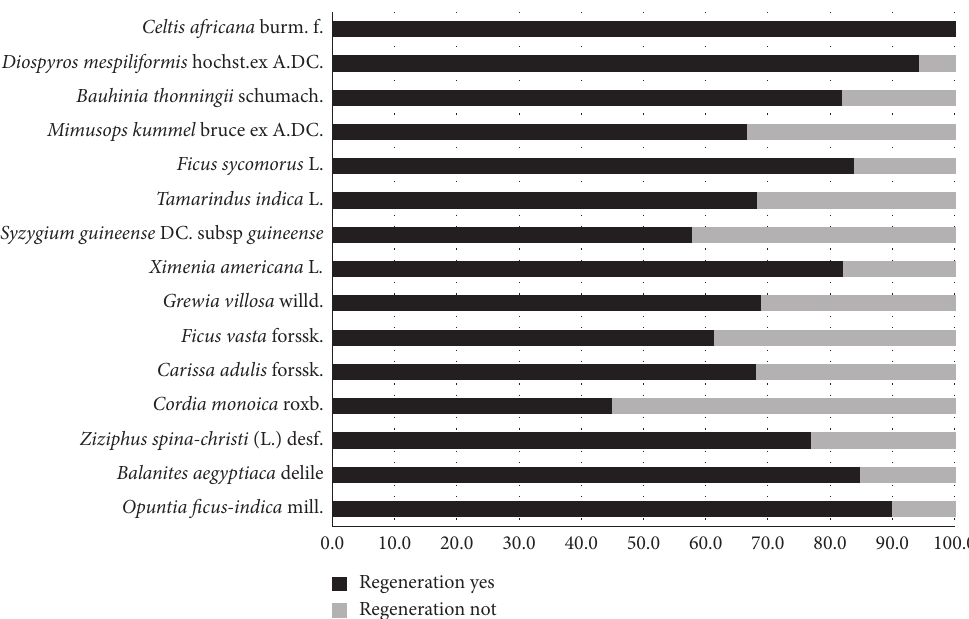
Figure 1: Regeneration status of Ximenia americana in low lands of Ethiopia. Source: Dejene et al.